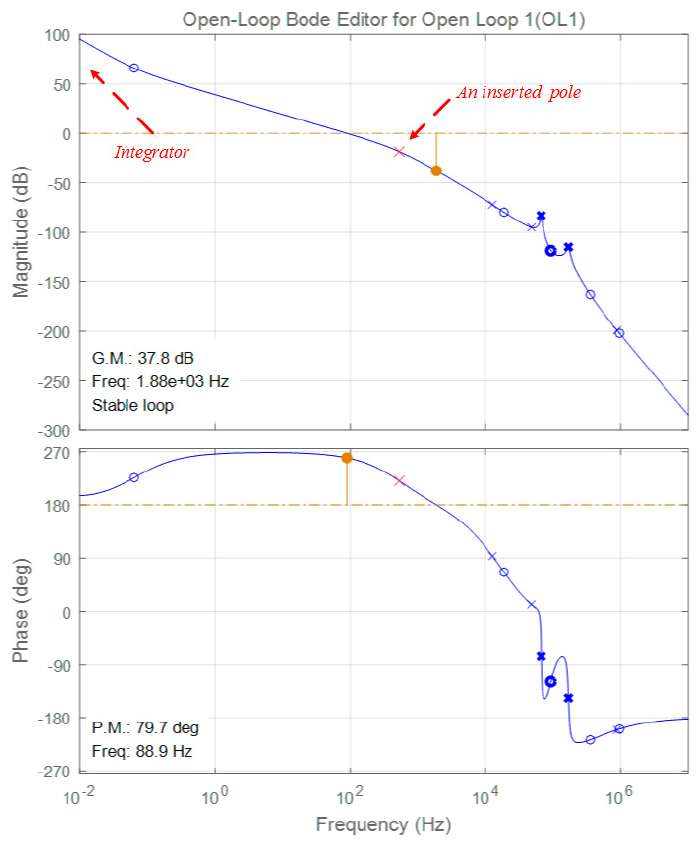
Figure 11. Magnitude and phase plot of loop gains with the designed compensator.